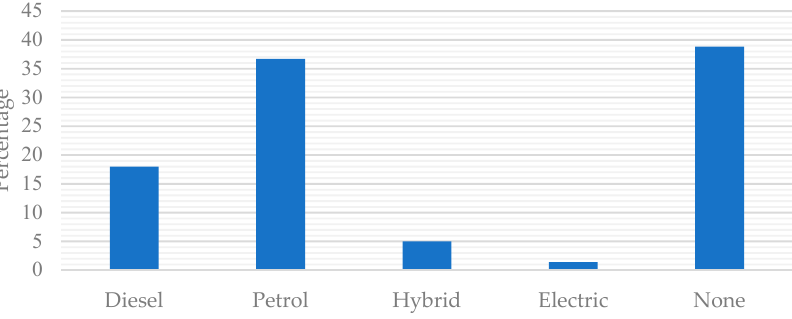
Figure 2. Type of vehicle owned.